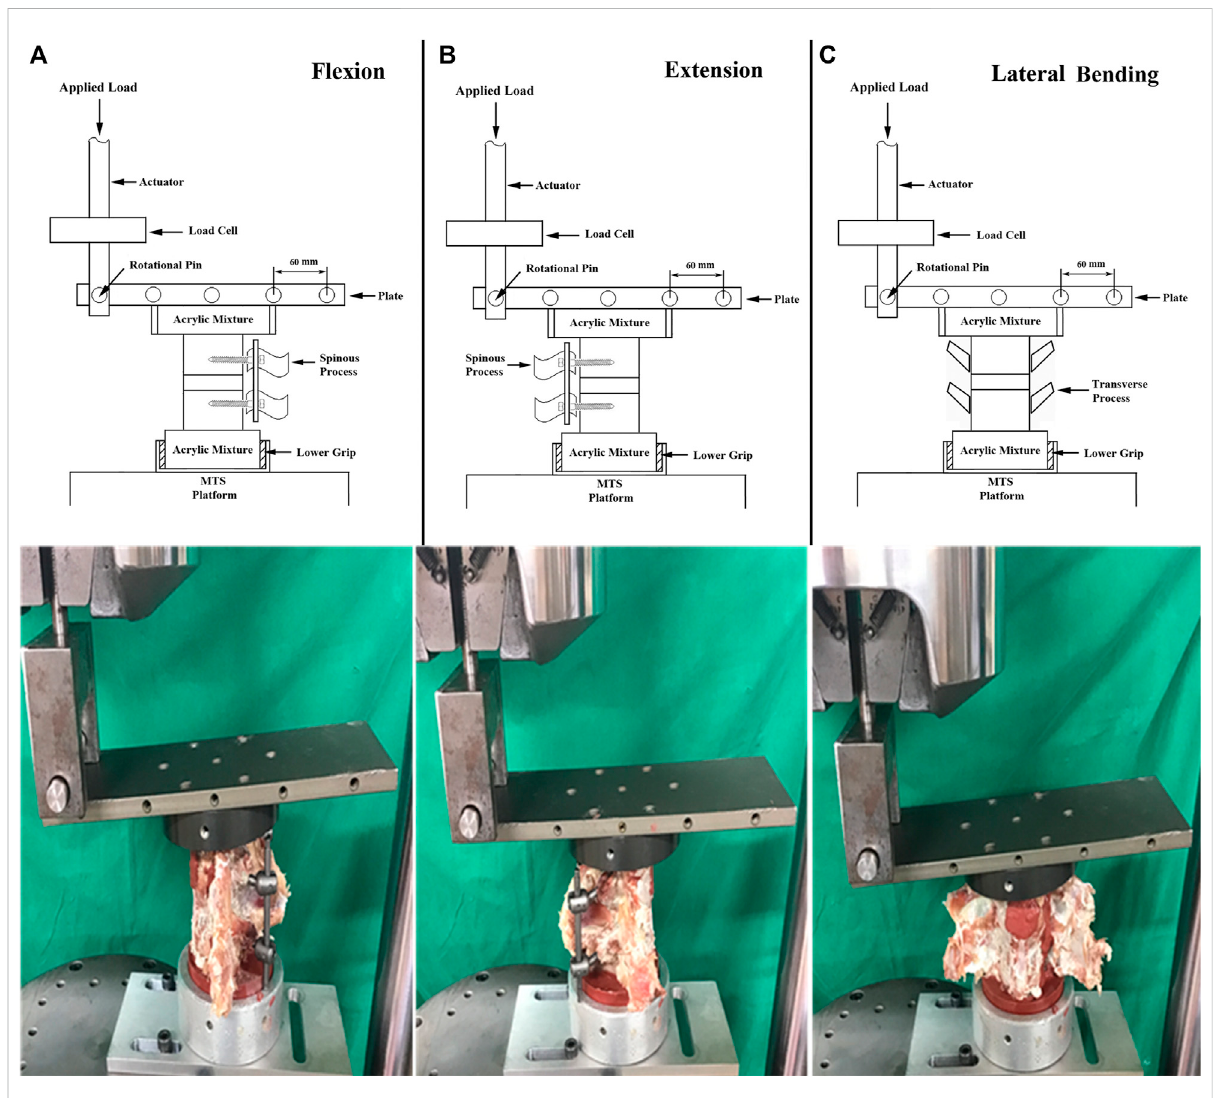
Schematic drawings (upper) and photographs showing the experimental setup for (A) fl exion, (B) extension, and (C) lateral bending of the FSU constructs. The tests were performed on a biaxial (axial and rotation) MTS machine. A maximal 8,400 N-mm moment generated through the axial movement of the MTS actuator was applied to the spine specimen to achieve fl exion, extension and lateral bending